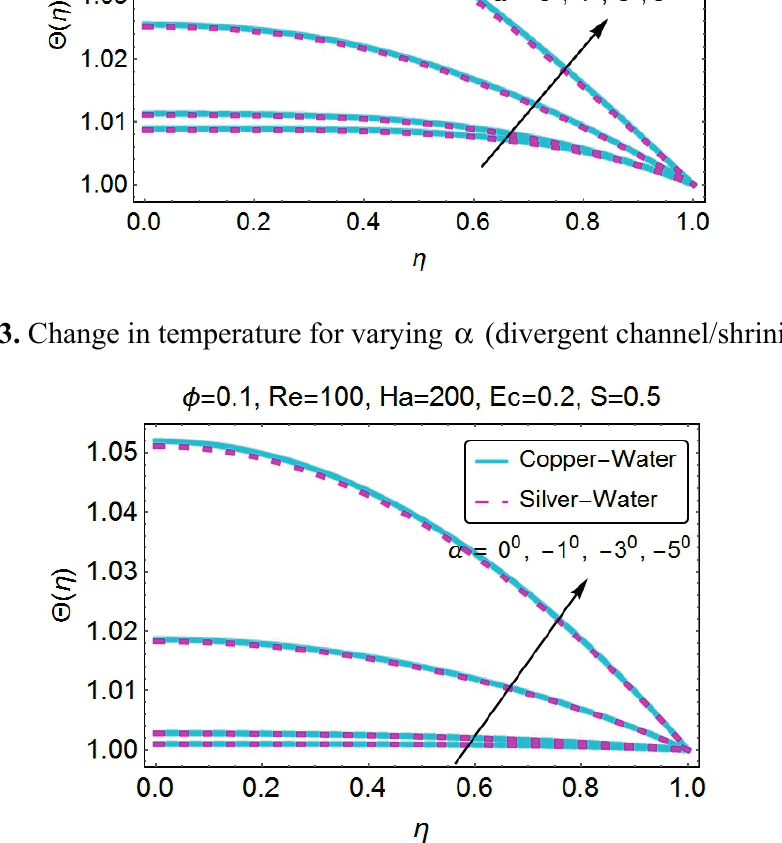
Figure 14. Change in temperature for varying α (convergent channel/stretching case).